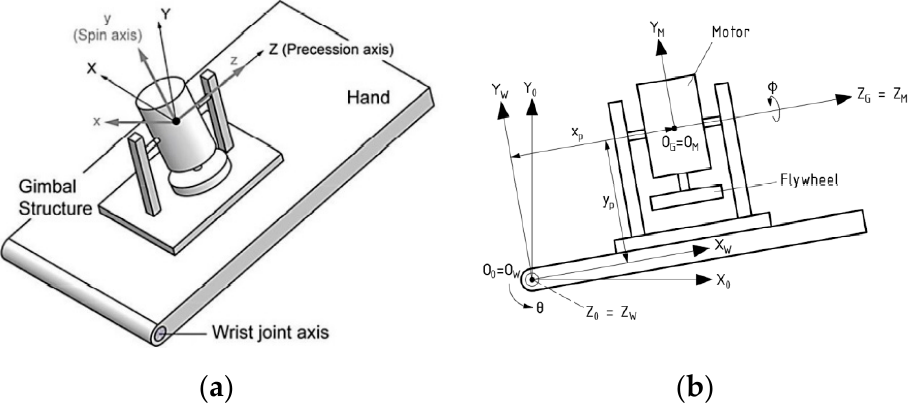
Figure 3. Modeling of the gyroscopic system: ( a ) 3D view and ( b ) coordinate-attached analysis. The inertial coordinate { O } : X 0 Y 0 Z 0 with an origin at the central point of the wrist joint; Z 0 coincides with the wrist joint axis, and Y 0 coincides with the gravity force.